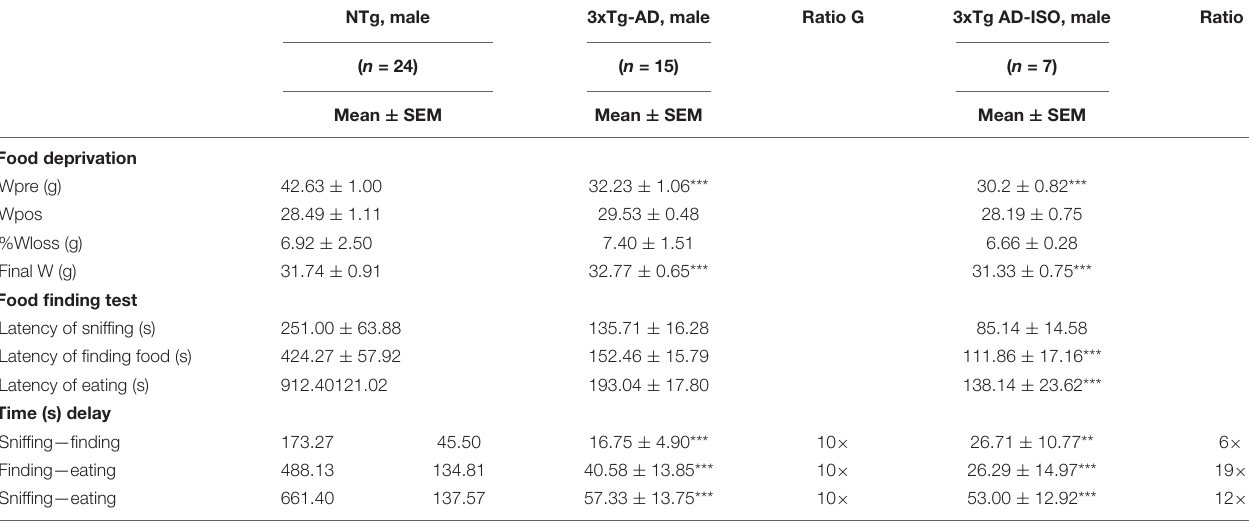
TABLE 2 | Effects of naturalistic isolation of male 3xTg-AD mice in food deprivation, food finding test, and the time delay between actions. NTg,